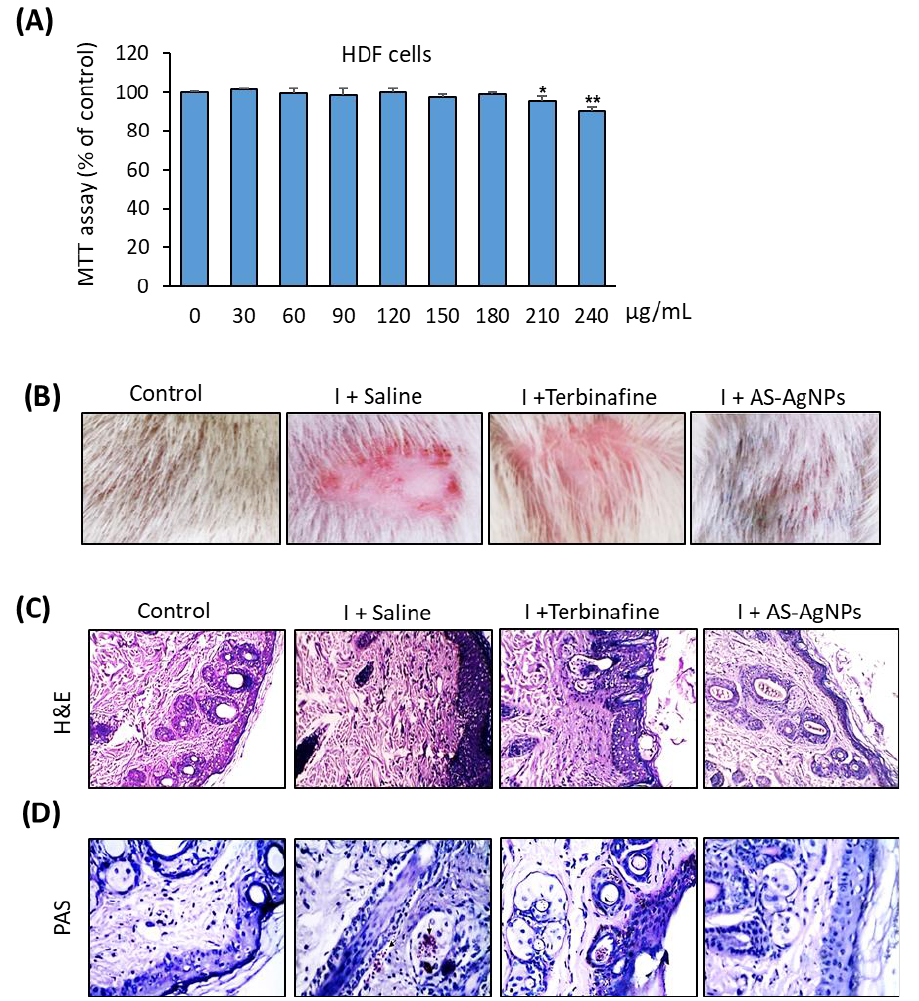
Figure 7. Skin histological analysis of rat dermatophytosis model. ( A ) Cytotoxicity of AS-AgNPs on primary HDF cells. Cell viability was measured by MTT assay after 48 h of incubation at different concentrations of AS-AgNPs. Values are mean ± SD of three independent experiments (* p < 0.05, ** p < 0.05 compared to control non-treated cells). ( B ) Representative images of infected skin tissue taken on day 14 post treatment. Groups are as follows: control (non-infected), I + Control (infected rat with saline treatment), I + Terbinafine (infected rat treated with terbinafine (10 mg/kg) and I + AS-AgNPs (infected rat treated with AS- AgNPs (0.5 μg/g)). Skin tissue sections stained with H&E ( C ) and periodic acid – Schiff (PAS) ( D ). I + Terbinafine displayed slight effect on thickness of epider- mis of skin, and fungal fragments were still identified in the epidermis and the hair follicle (PAS). The AS-AgNP-treated group showed complete recovery of skin structure (H&E) with an absence of fungal cells.